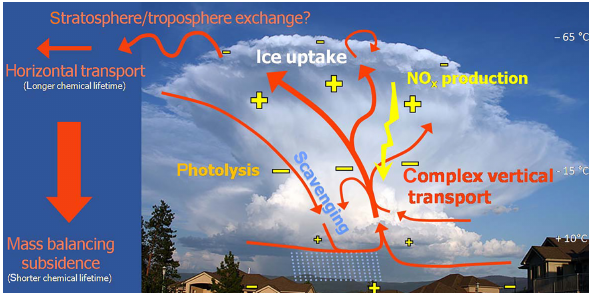
Figure 1. Scheme of the relevant characteristics and processes of a thunderstorm